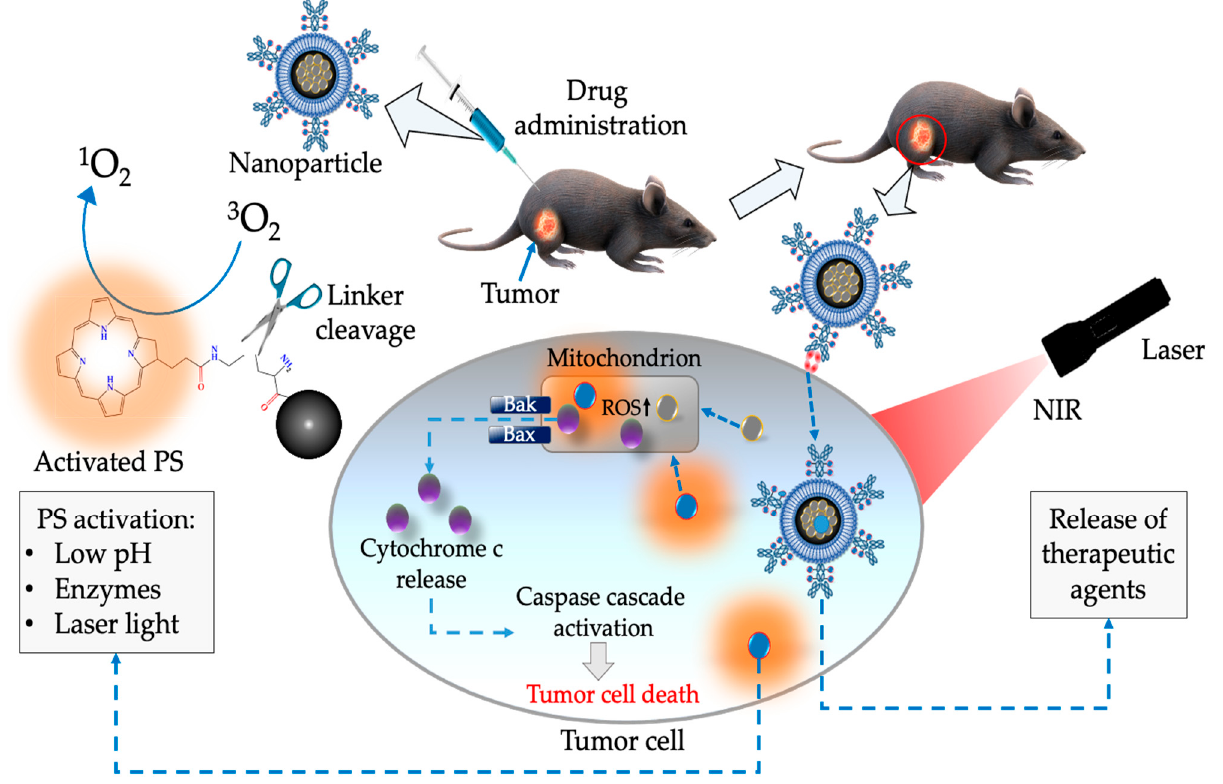
Figure 6. A schematic diagram illustrating the administration and therapeutic effects of functionalized nanoparticles in cancer PDT.